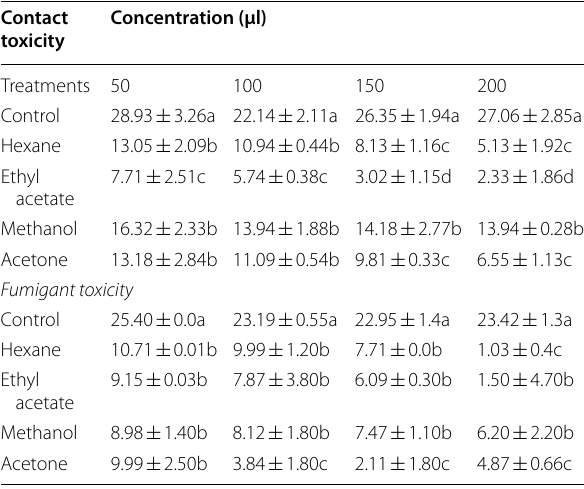
Table 2 Effect of Secamone afzelii extracts on percentage weight